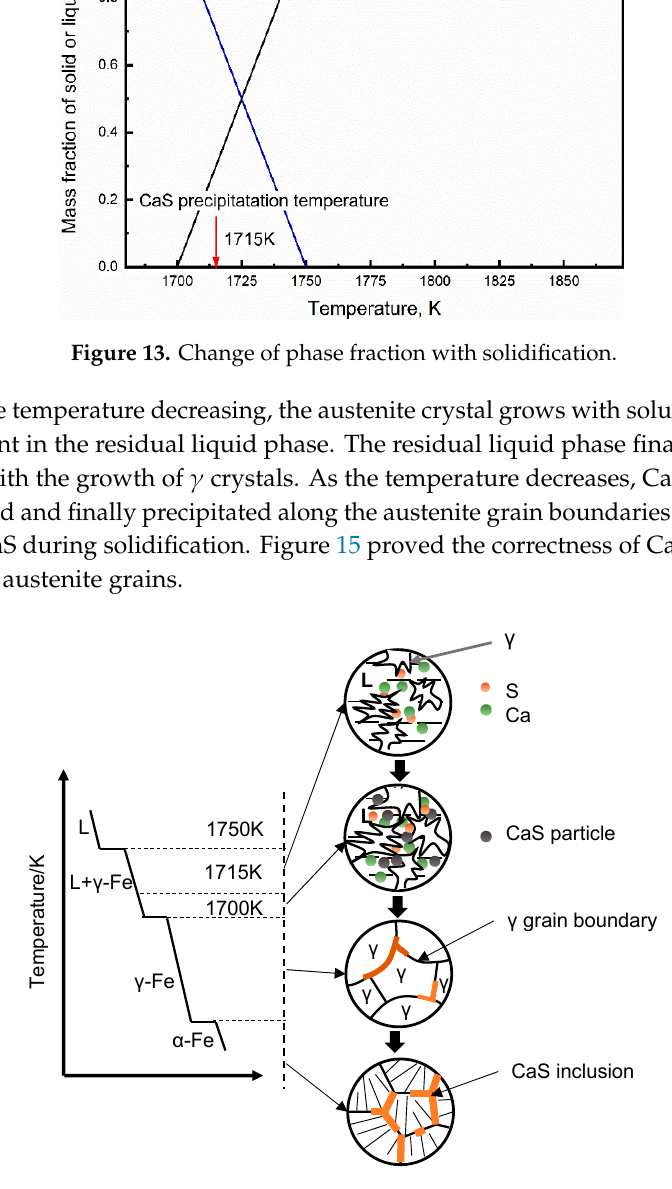
Figure 14. Schematic illustration of formation of CaS during steel solidification.